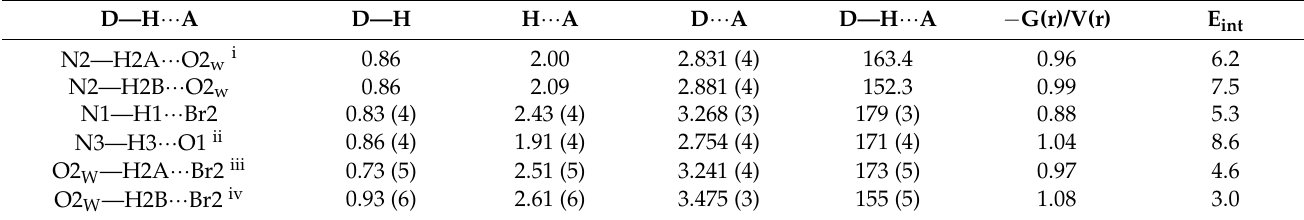
Table 2. Hydrogen-bond geometry (Å, °) and topological analysis for compound (II) . E int is reported in kcal/mol. For additional details concerning QTAIMS results see Tables S2–S4 in the Supporting Information.